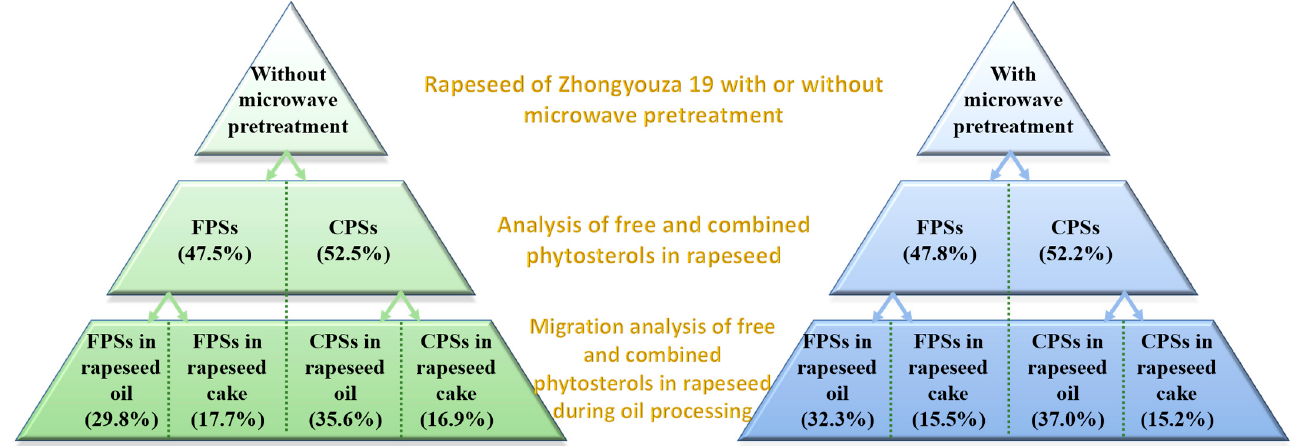
Figure 10. The dynamic changes of combined and free phytosterols in rapeseed of Zhongyouza 19 during oil processing with/without microwave pretreatment of rapeseed. CPSs: combined phytosterols; FPSs: free phytosterols. Values are the means ± standard deviations; n = 3 parallel determinations.